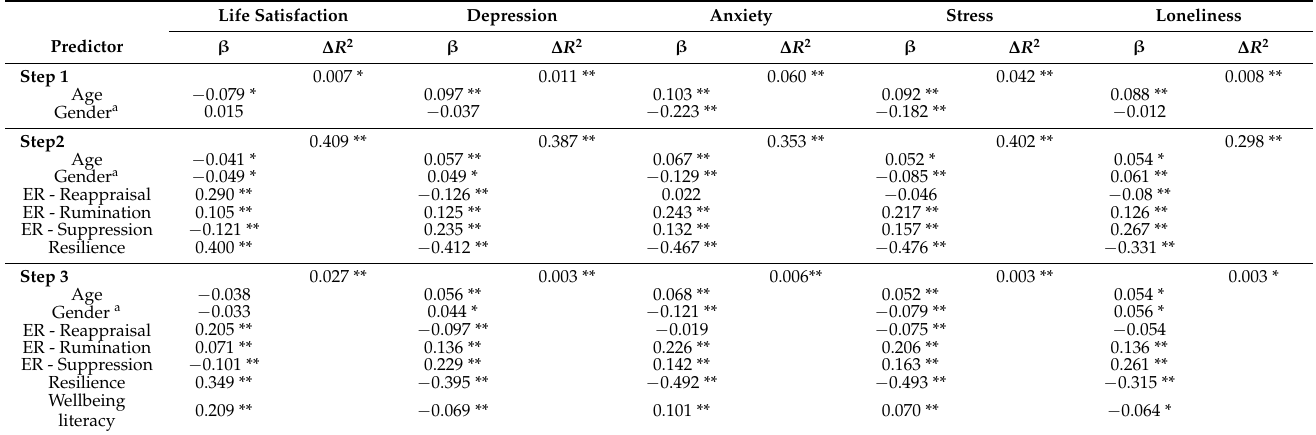
Table 5. Results of hierarchical multiple regression